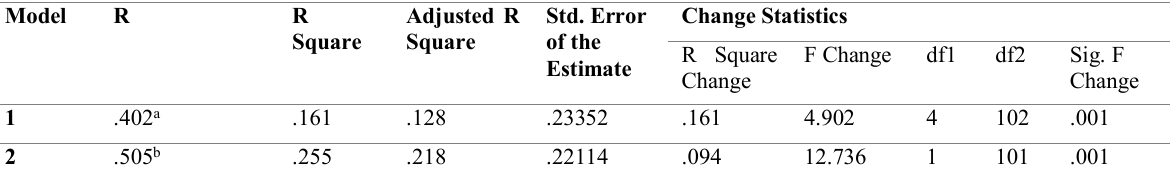
Table 13: Regression model summary after moderation